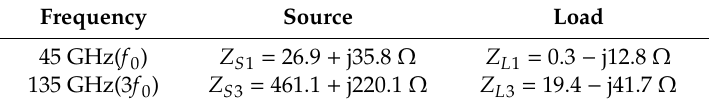
Figure 4. Contours for 3rd harmonic power with step of 2 dB for input power of 19.0 dBm at f 0 = 45 GHz. ( a ) Source ‐ pull contours at f 0 . ( b ) Load ‐ pull contours at 3 f 0 . Table 2. Optimum impedances determined by source ‐ and load ‐ pull simulation.